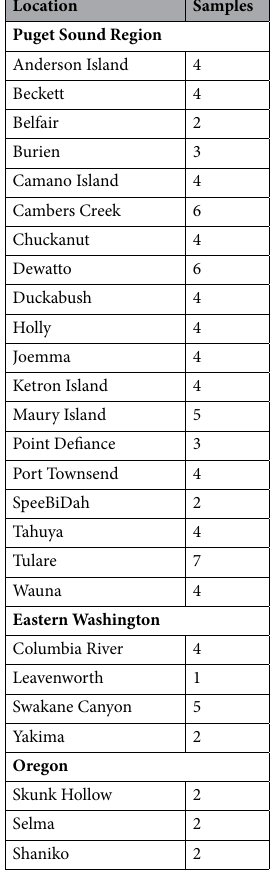
Table 1. Sample locations and sample sizes. Detailed voucher specimen information is provided in Table